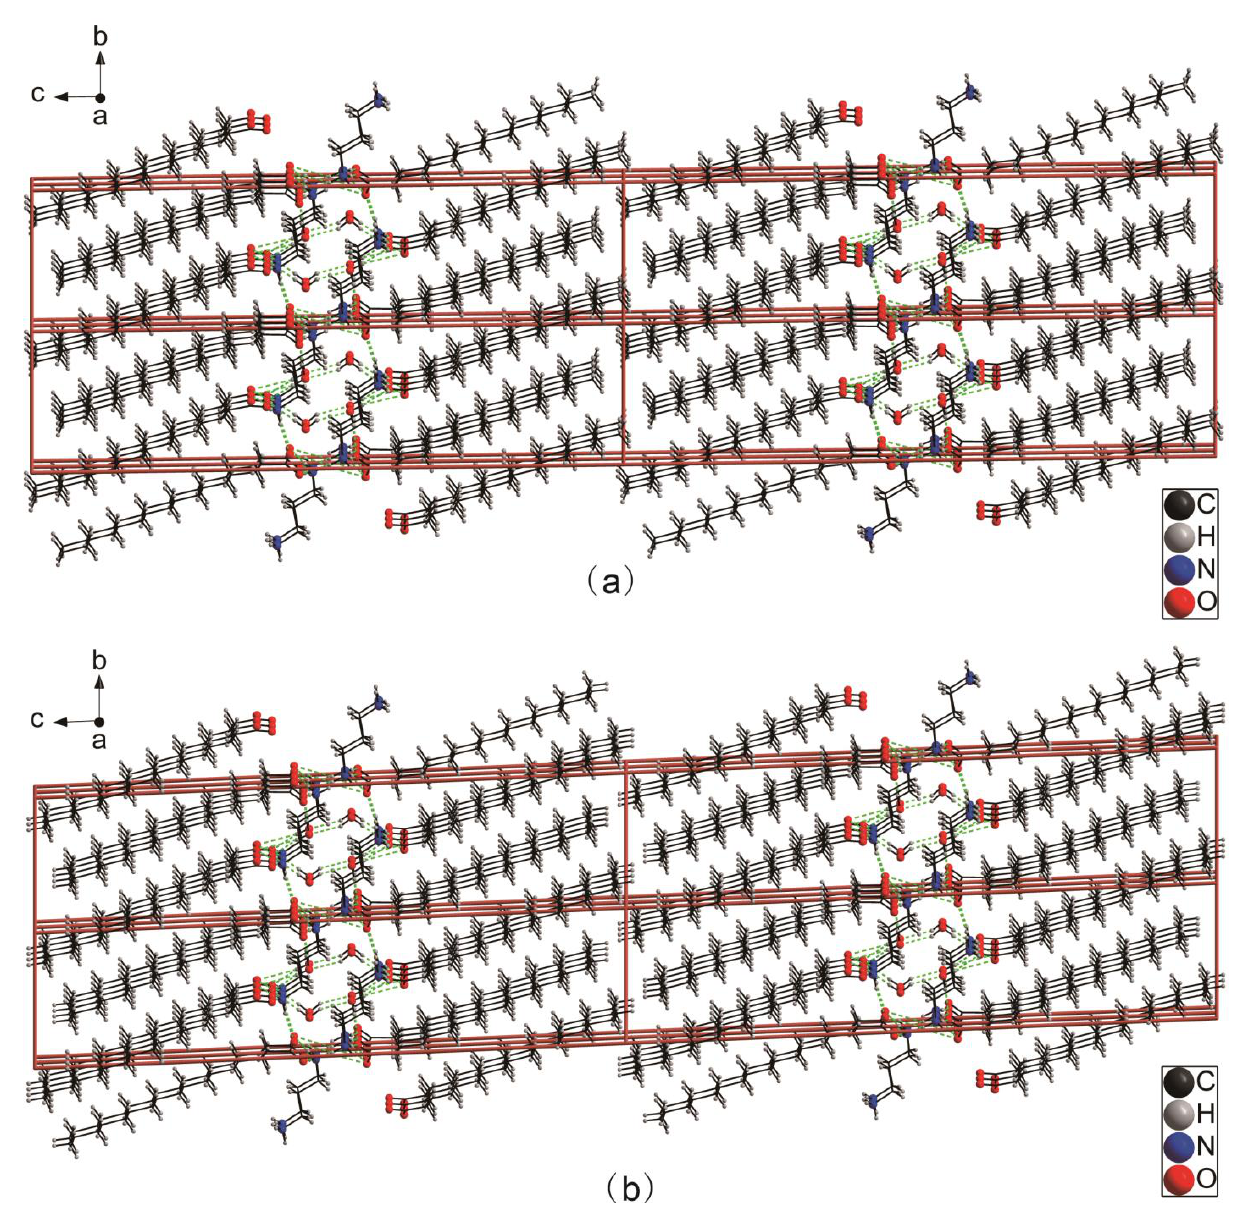
Figure 3. Three-dimensional stacking diagrams (2 × 2 × 2) of the two molecules: where ( a ) represents 3C16 and ( b ) represents 3C17.